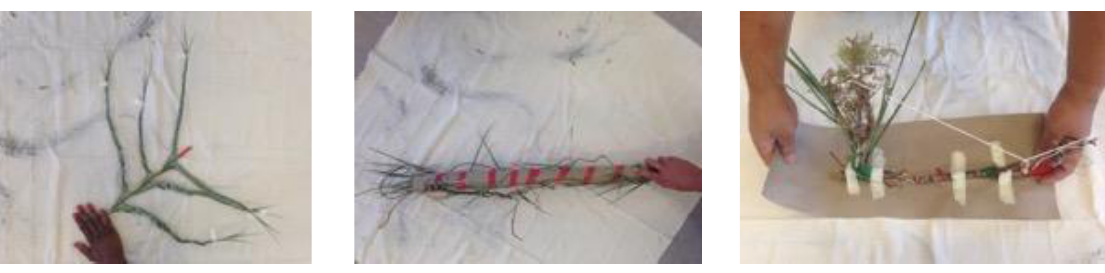
Figure 11 : Embracing Figure 12 : Strength together Figure 13 :